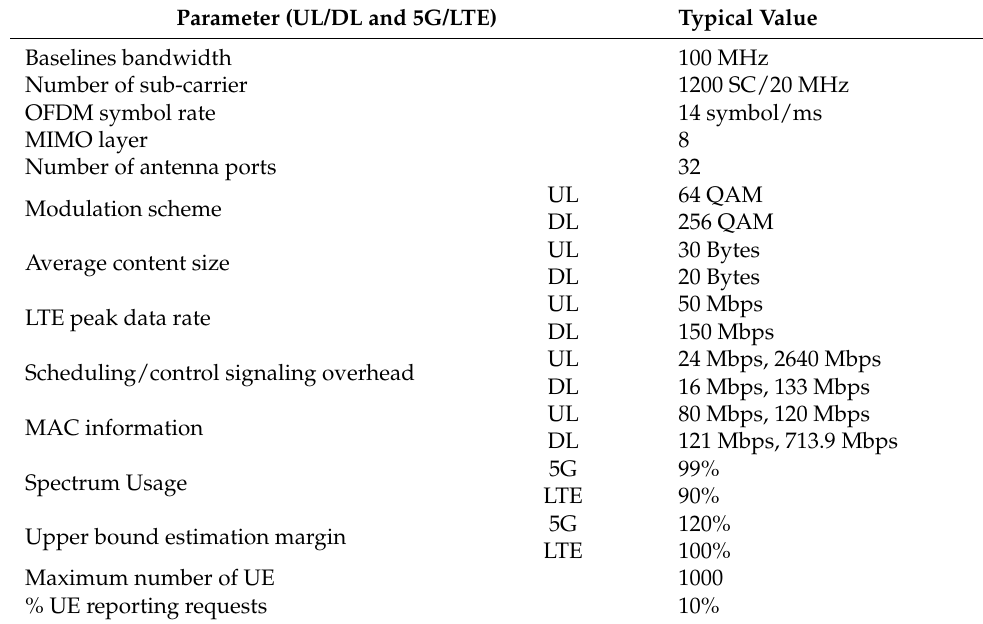
Figure 29. Required MFH capacity for different split options. Table 14. Typical transmission parameters